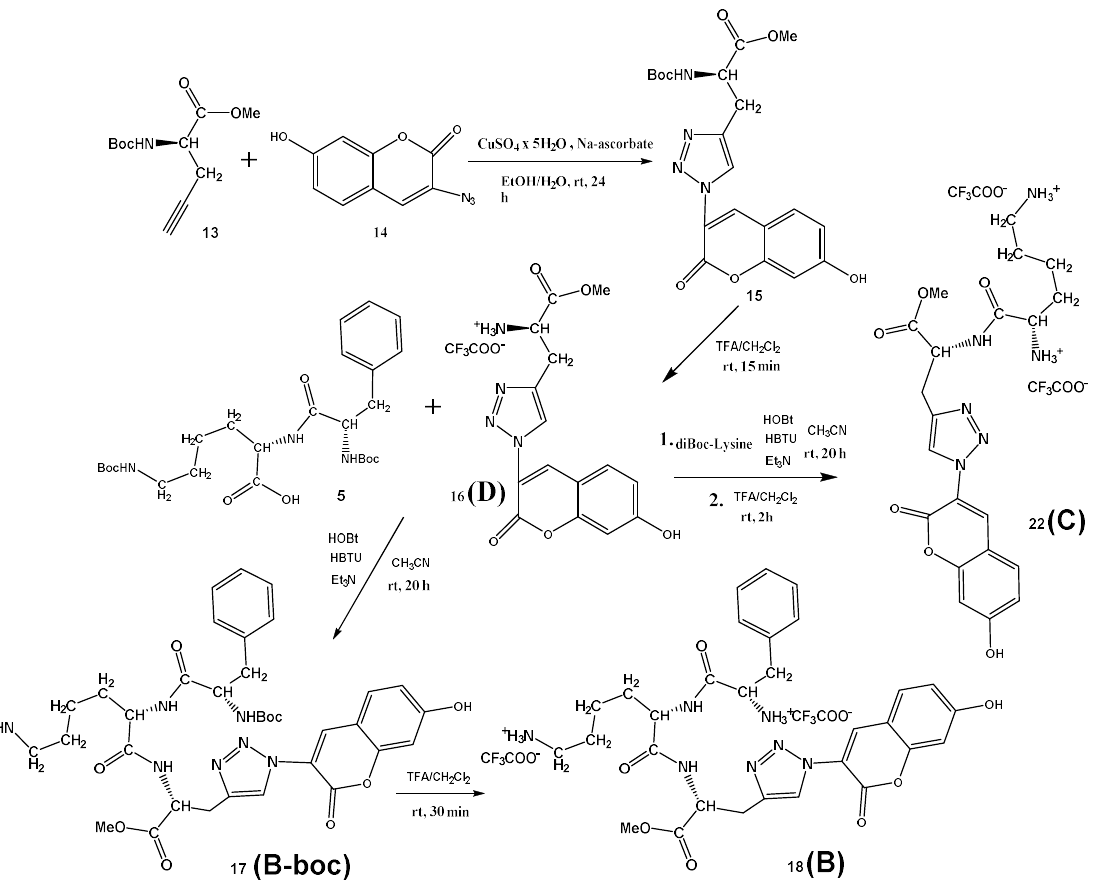
Table 1. Electronic absorption and emission data of B , B-boc , C and D at pH 7, sodium cacodylate buffer, c = 50